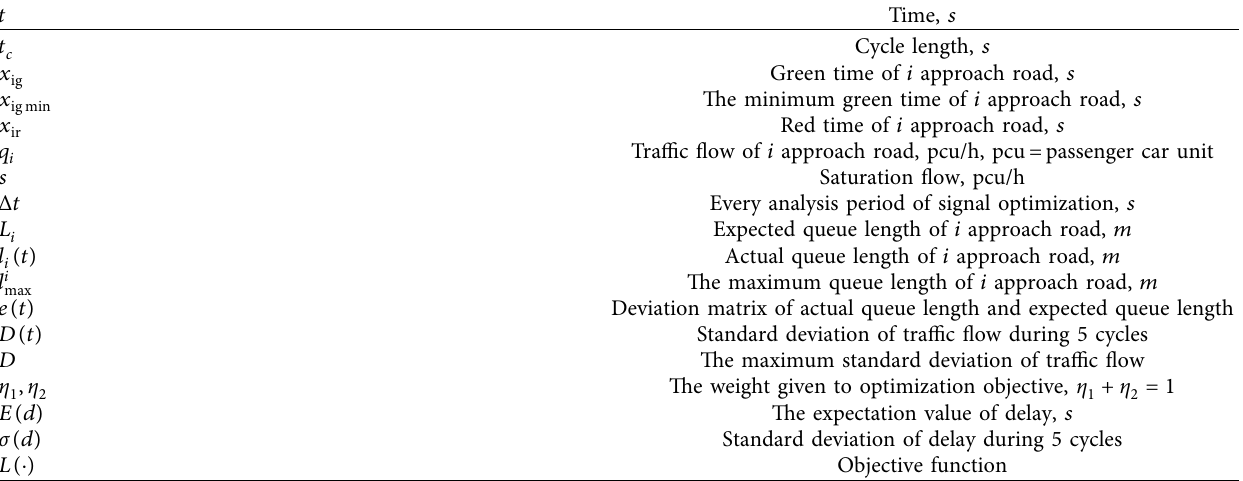
Table 1: Parameter descriptions.